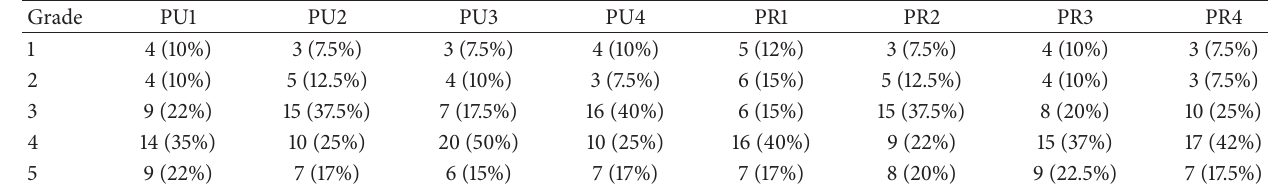
Table 4: Adjudication of discrepancies in VUR grade among pediatric urologists (PU) and pediatric radiologists